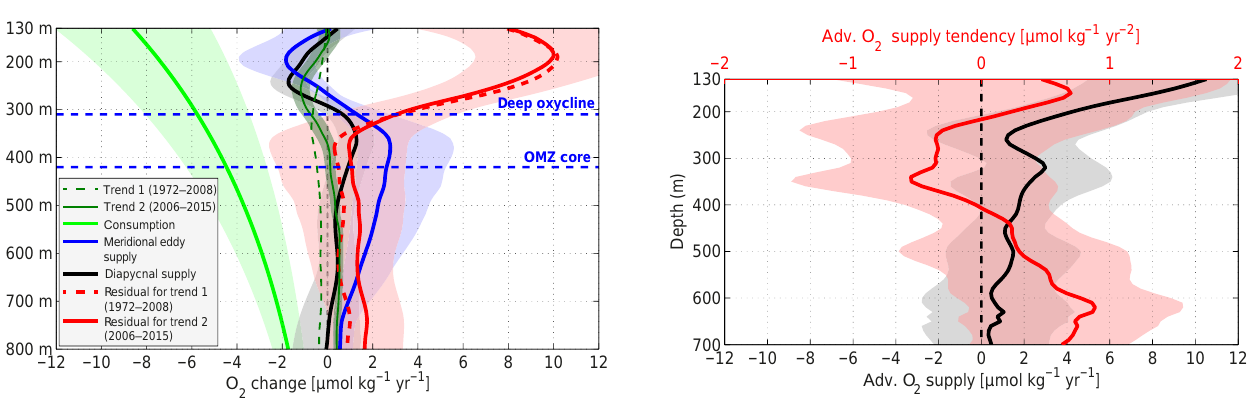
Figure 13. Oxygen budget for the ETNA as an average between 6 and 14 ◦ N (see Eq. (1) and corresponding text in Sects. 2.5, 3.4 and 4.3 for details). The terms consumption, meridional eddy sup- ply and diapycnal supply were kept constant in time, whereas two different oxygen trends for the periods 1972–2008 (multi-decadal trend: dashed green line) and 2006–2015 (decadal trend: solid green line) were implemented in the budget. The corresponding residual supply for both periods (multi-decadal: dashed red line – decadal: solid red line) was calculated by assuming a balance between all respective terms.